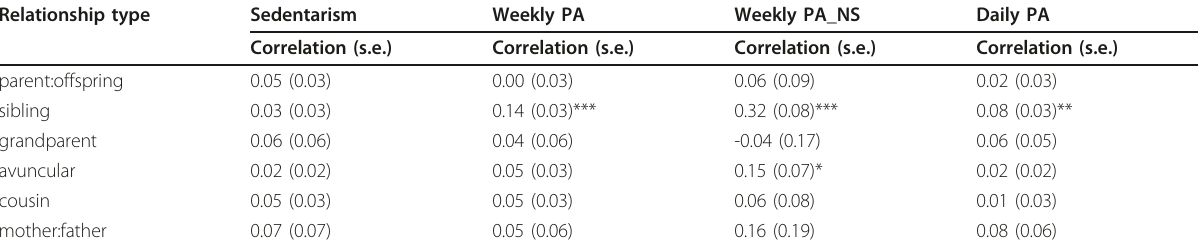
Table 3 Interclass and intraclass correlations in different pairs of relatives for the different phenotypes Relationship type Sedentarism Weekly PA Weekly PA_NS Daily PA Correlation (s.e.) Correlation (s.e.) Correlation (s.e.) Correlation